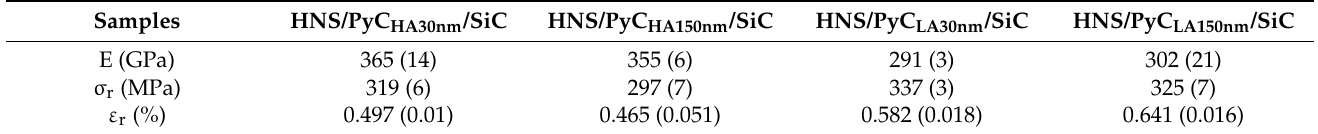
Table 6. Mechanical characteristics mean values of all SiC/SiC specimen types. () standard deviation.